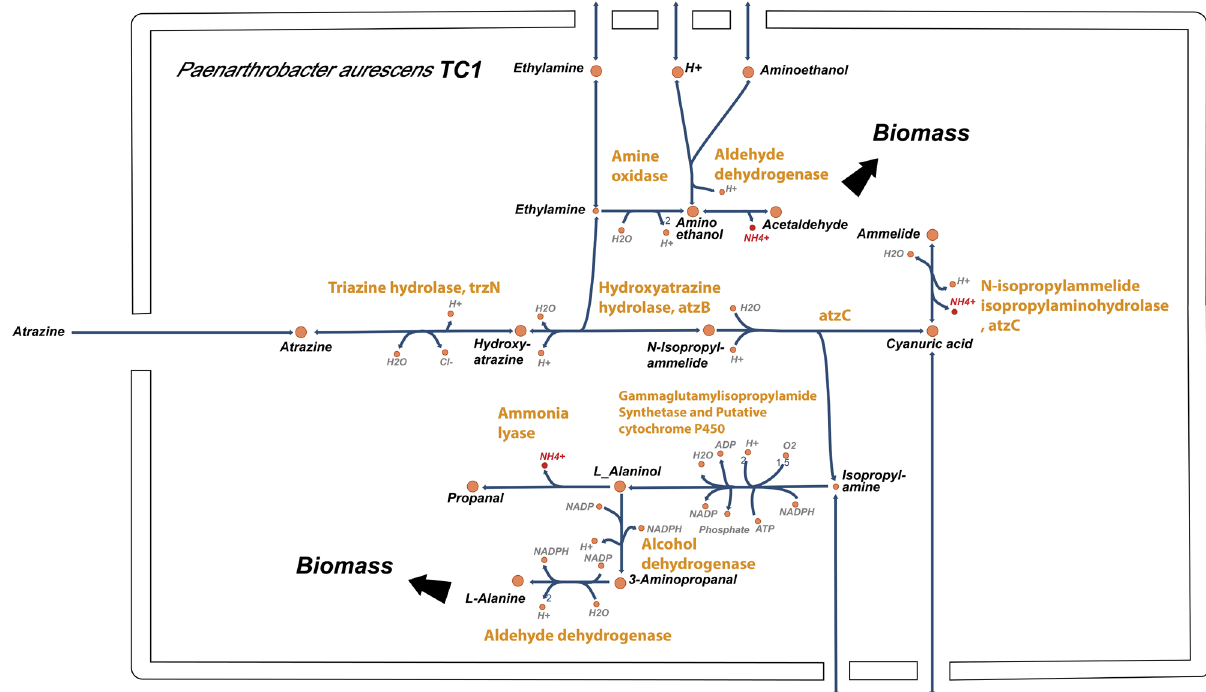
Figure 1. Atrazine metabolism as implemented in the cytoplasm compartment of P. aurescens TC1 genome scale metabolic model reconstruction ( i RZ1179). Reaction (enzyme) names are written in